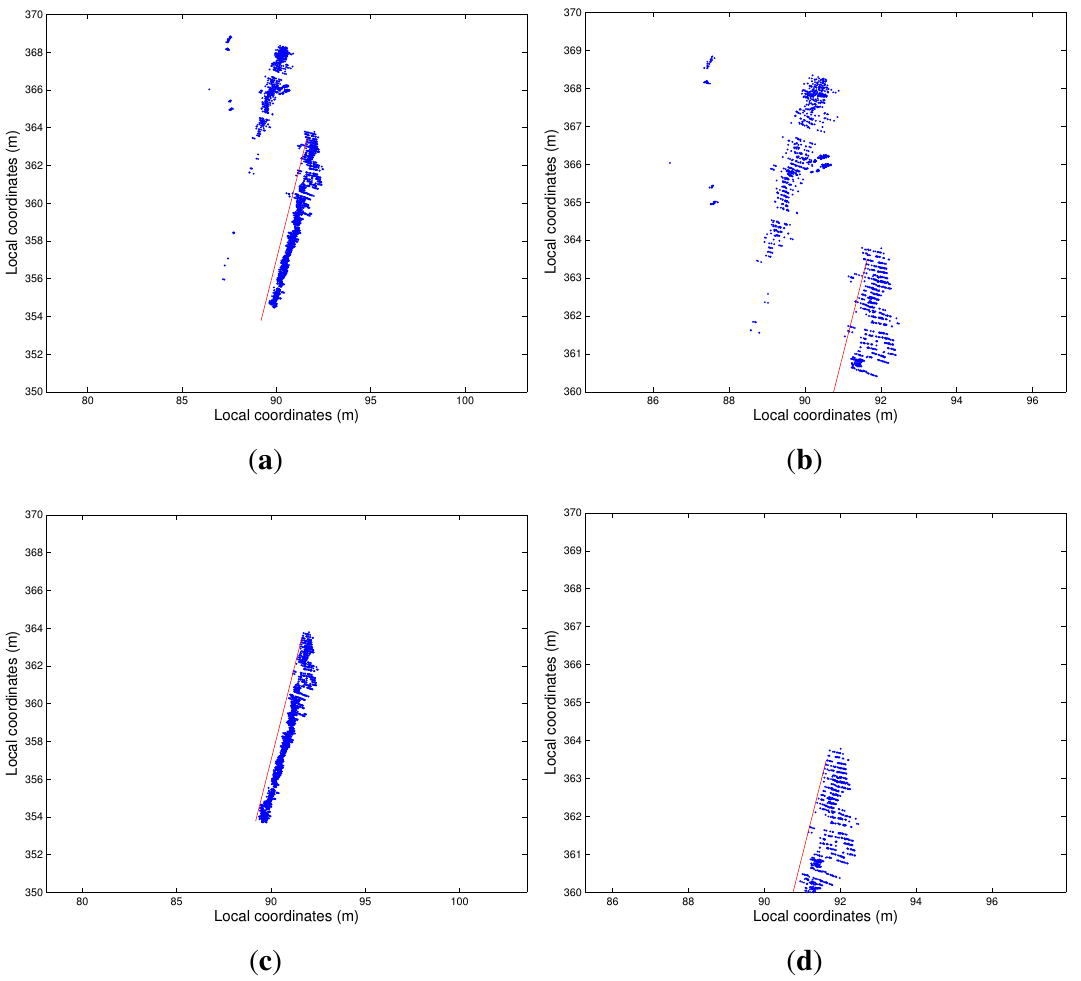
Figure 19. Result of the line filter application. The figures are shown in a birds-eye view. ( a ) Non-filtered points; ( b ) non-filtered points; ( c ) filtered points; ( d ) filtered